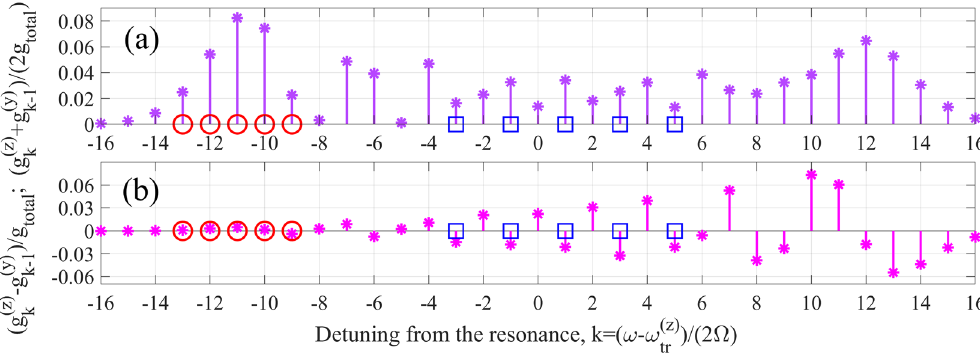
Figure 3. Half-sum ( a ) and difference ( b ) of the effective gain factors for the XUV radiation of z -polarization (5a) and y -polarization (5b). Red circles and blue squares mark the values of detuning, assumed in Fig. 4 and Fig. 5,